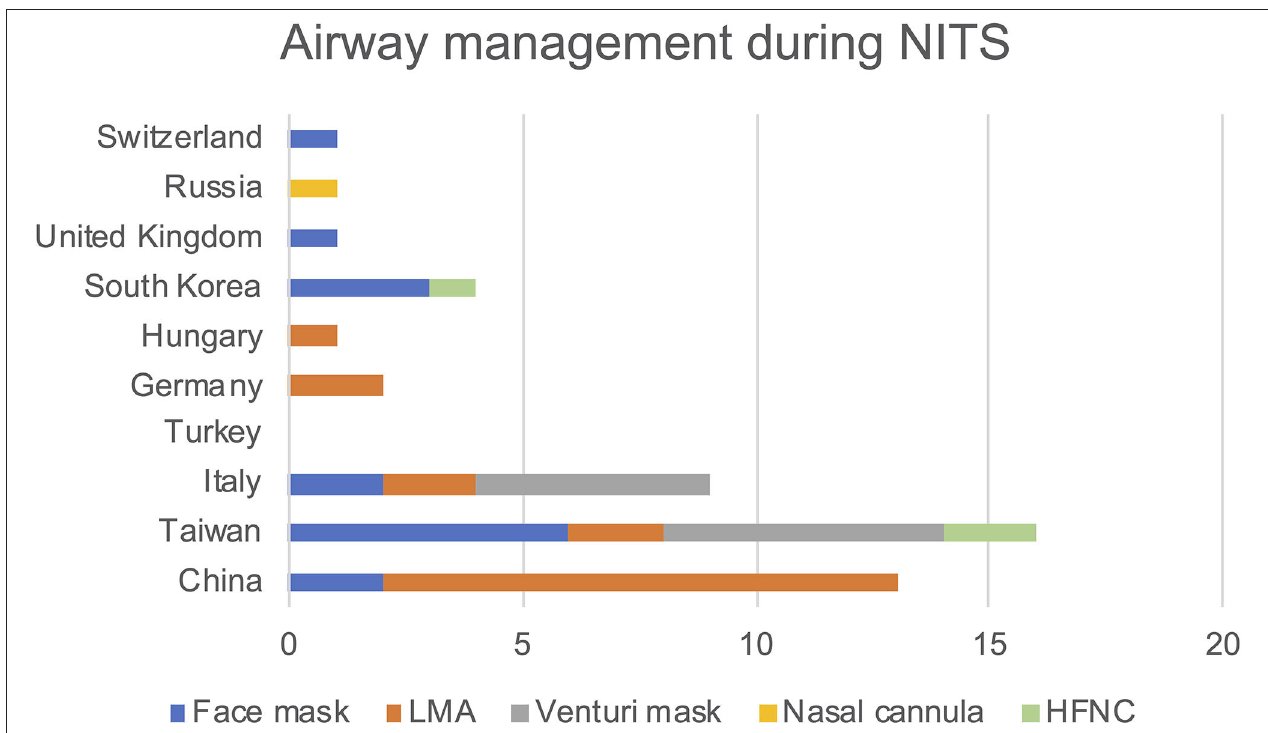
FIGURE 3 | Frequency of airway management devices used within the various clinical trials divided by country of the primary country in which the study was